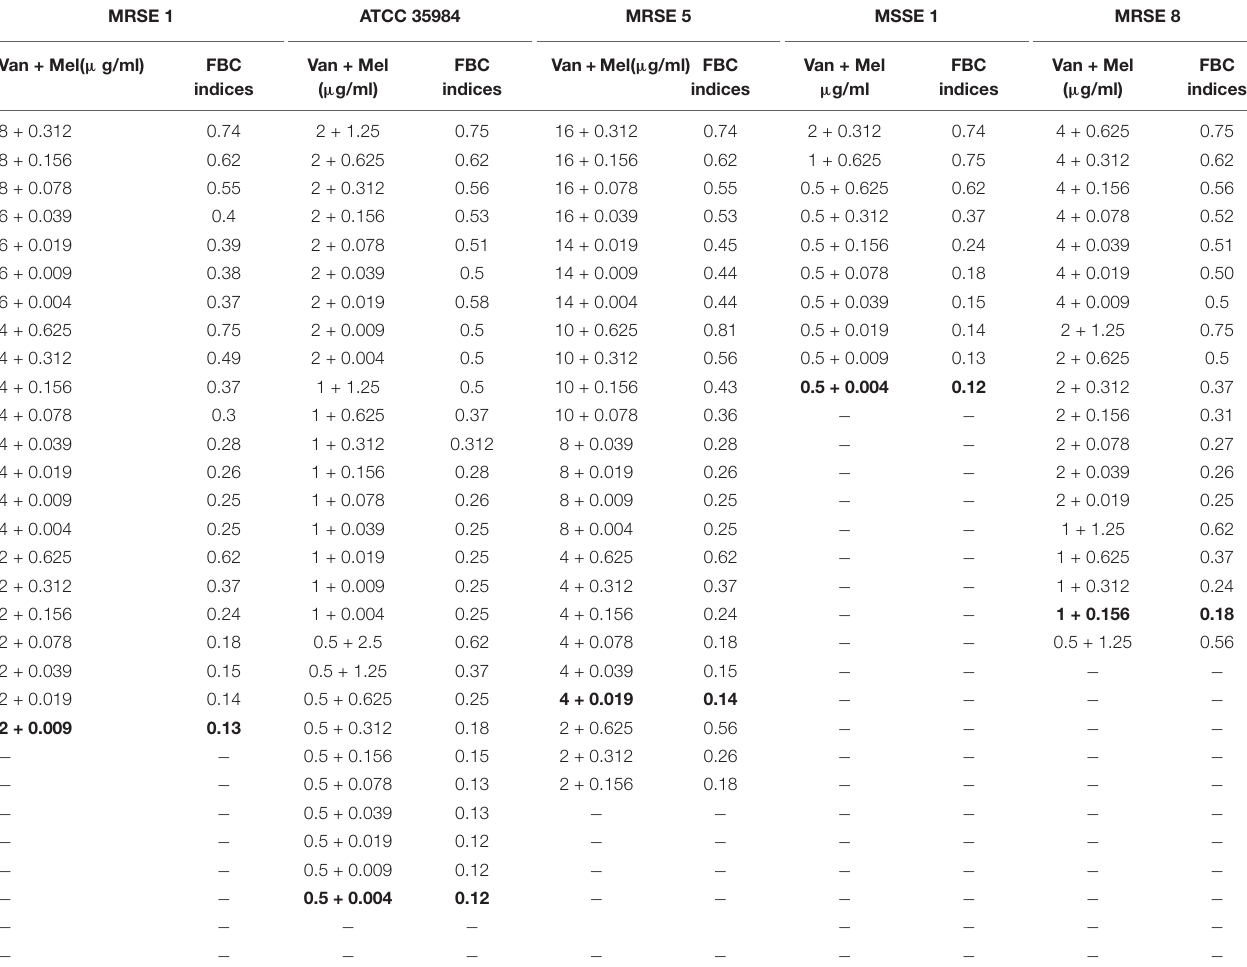
TABLE 6 | The best synergistic concentrations of Vancomycin-Melittin based on MBC against selected isolates. MRSE